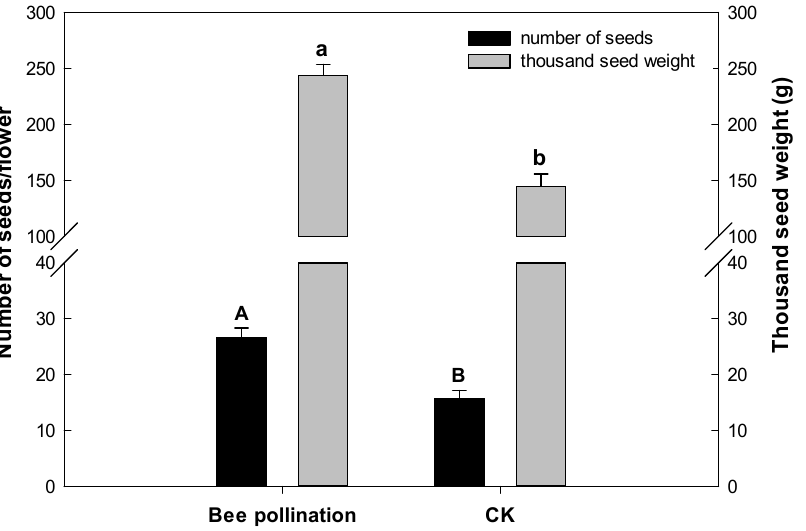
Figure 4. Efficiency of pollination by A. mellifera for P. lactiflora CK, P. lactiflora without bee pollination. The significance of the data was analyzed using Tukey’s test at p < 0.05.